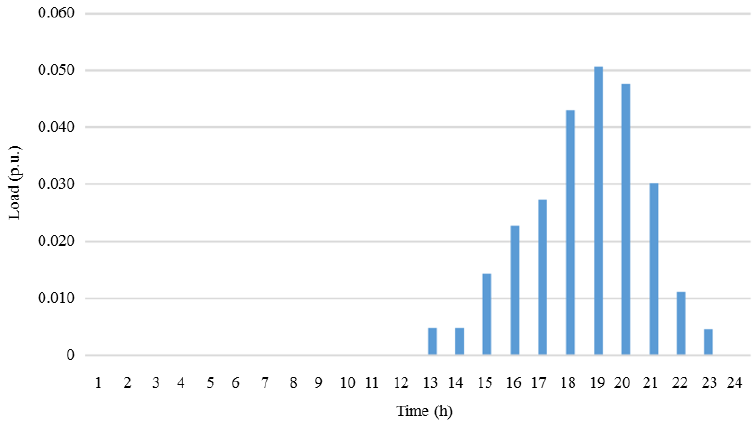
Figure 11. Load demand comparison between the base case and Case 3 (30 EVs, uncontrolled charging).